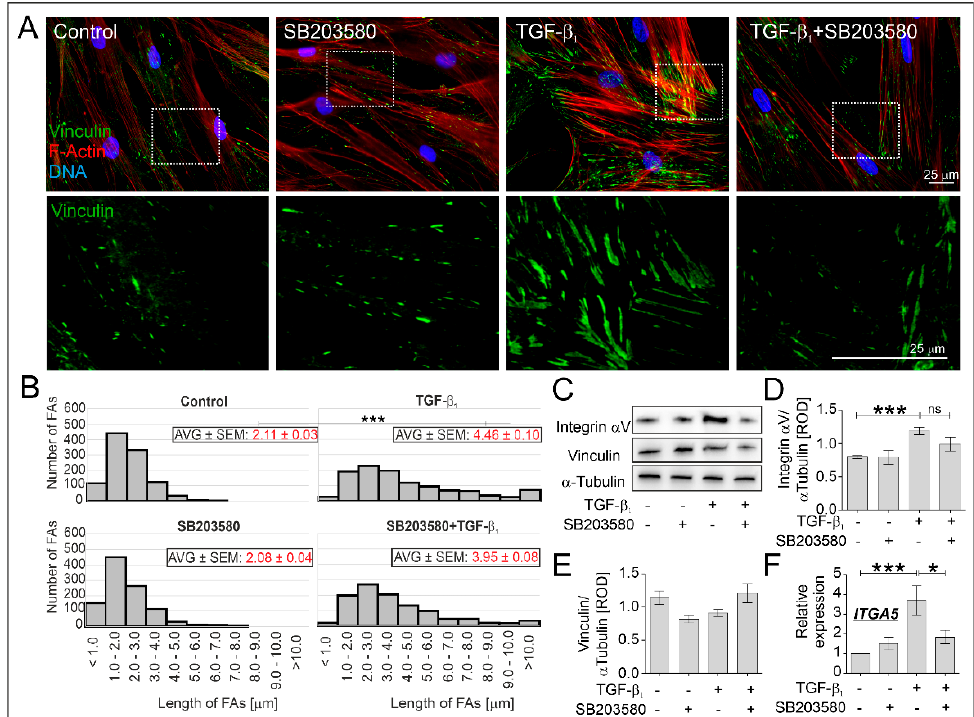
Figure 4. SB203580 affected the vinculin-rich and integrin-mediated adhesion sites in TGF- β 1 -treated HBFs AS. HBF AS populations ( n = 3) were cultured without or with SB203580 (10 µ M) in the absence or presence of TGF- β 1 (5 ng/mL) for five days. Then, the HBFs AS were immunostained for vinculin (green), counterstained for F-actin (red) and DNA (blue), and the vinculin-rich FAs were imaged using a fluorescence microscope with a TIRF module. ( A ) Representative images of FAs were presented (scale bar = 25 µ m), the marked box has been enlarged and presented in the bottom row, ( B ) quantified (average (AVG) length of at least 200 FAs per condition in boxes ± SEM) and grouped by size. ( C ) The protein levels of vinculin and integrin α V in HBF AS cultures ( n = 3) were determined by Western blot and ( D , E ) quantified. Representative membranes were shown. ( F ) Relative expression levels of ITGA5 (encoding integrin α 5) in HBFs AS ( n = 4) cultured for one day in conditions described above were presented as a 2 − ∆∆ Ct mean value in relation to control genes ( 18S , B2M and GAPDH ) and control conditions. Statistical significance was tested using the non-parametric Kruskal–Wallis test with Dunn’s Multiple Comparison post hoc test; * p < 0.05; *** p < 0.001; ns—not statistically